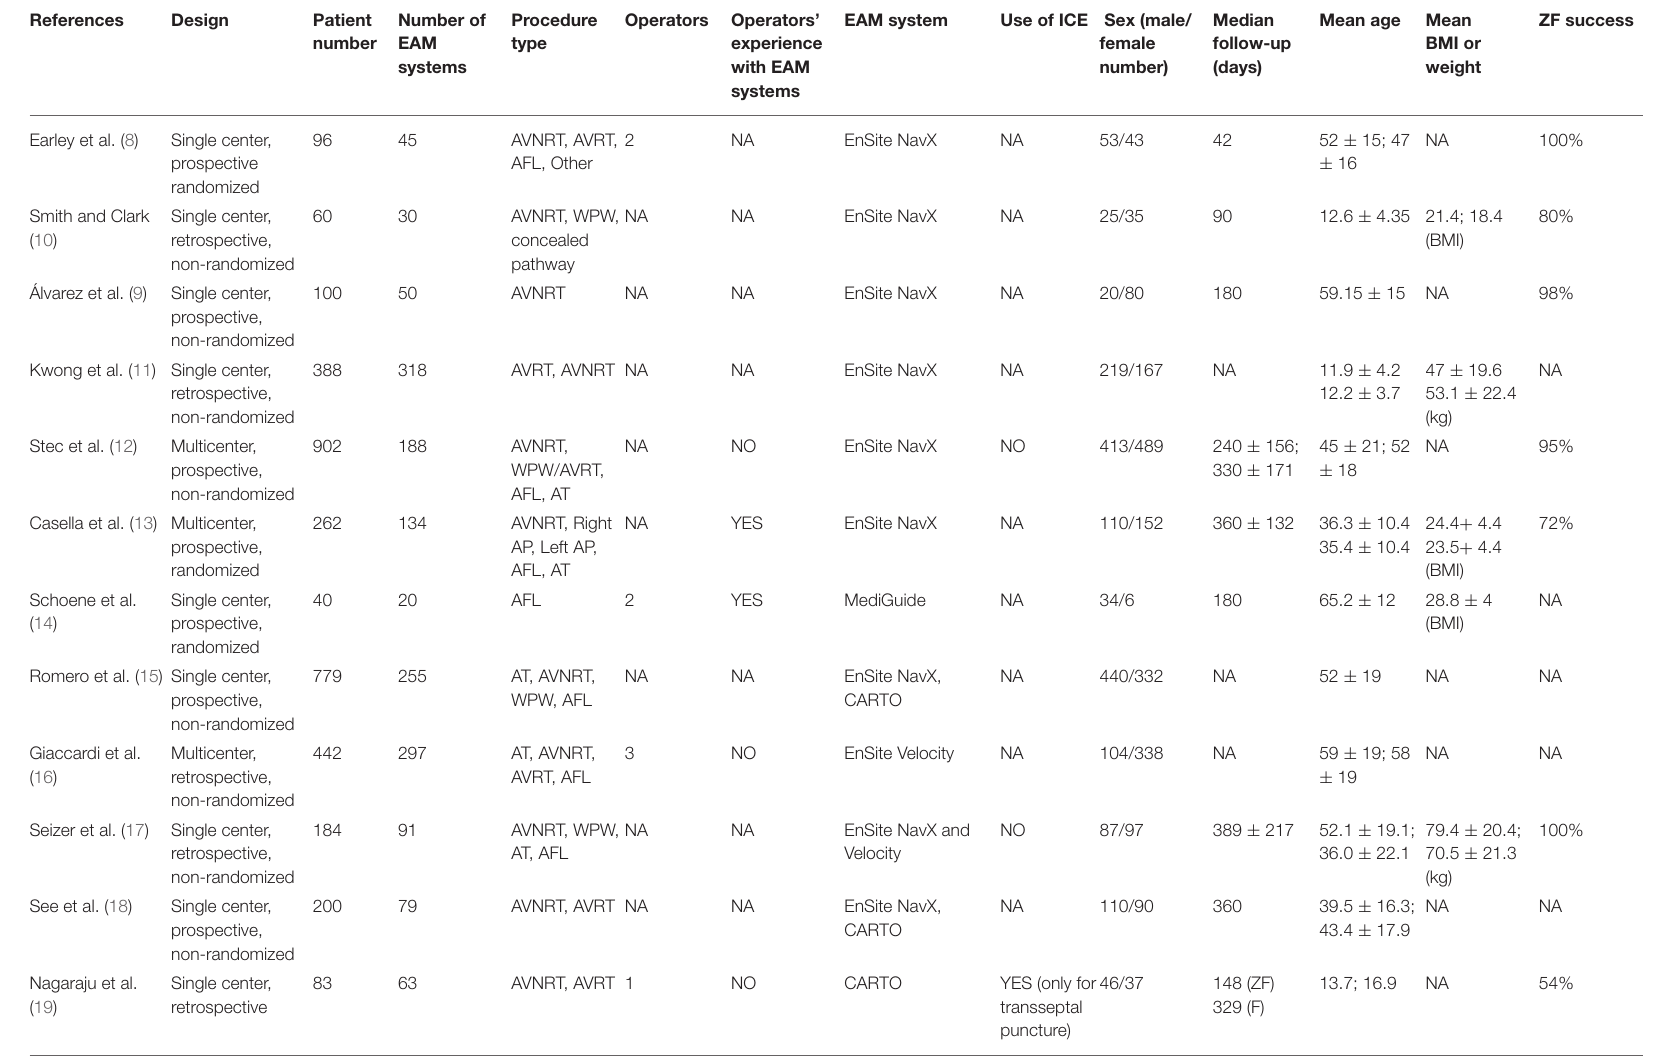
TABLE 1 | Study and patients’ characteristics of the included